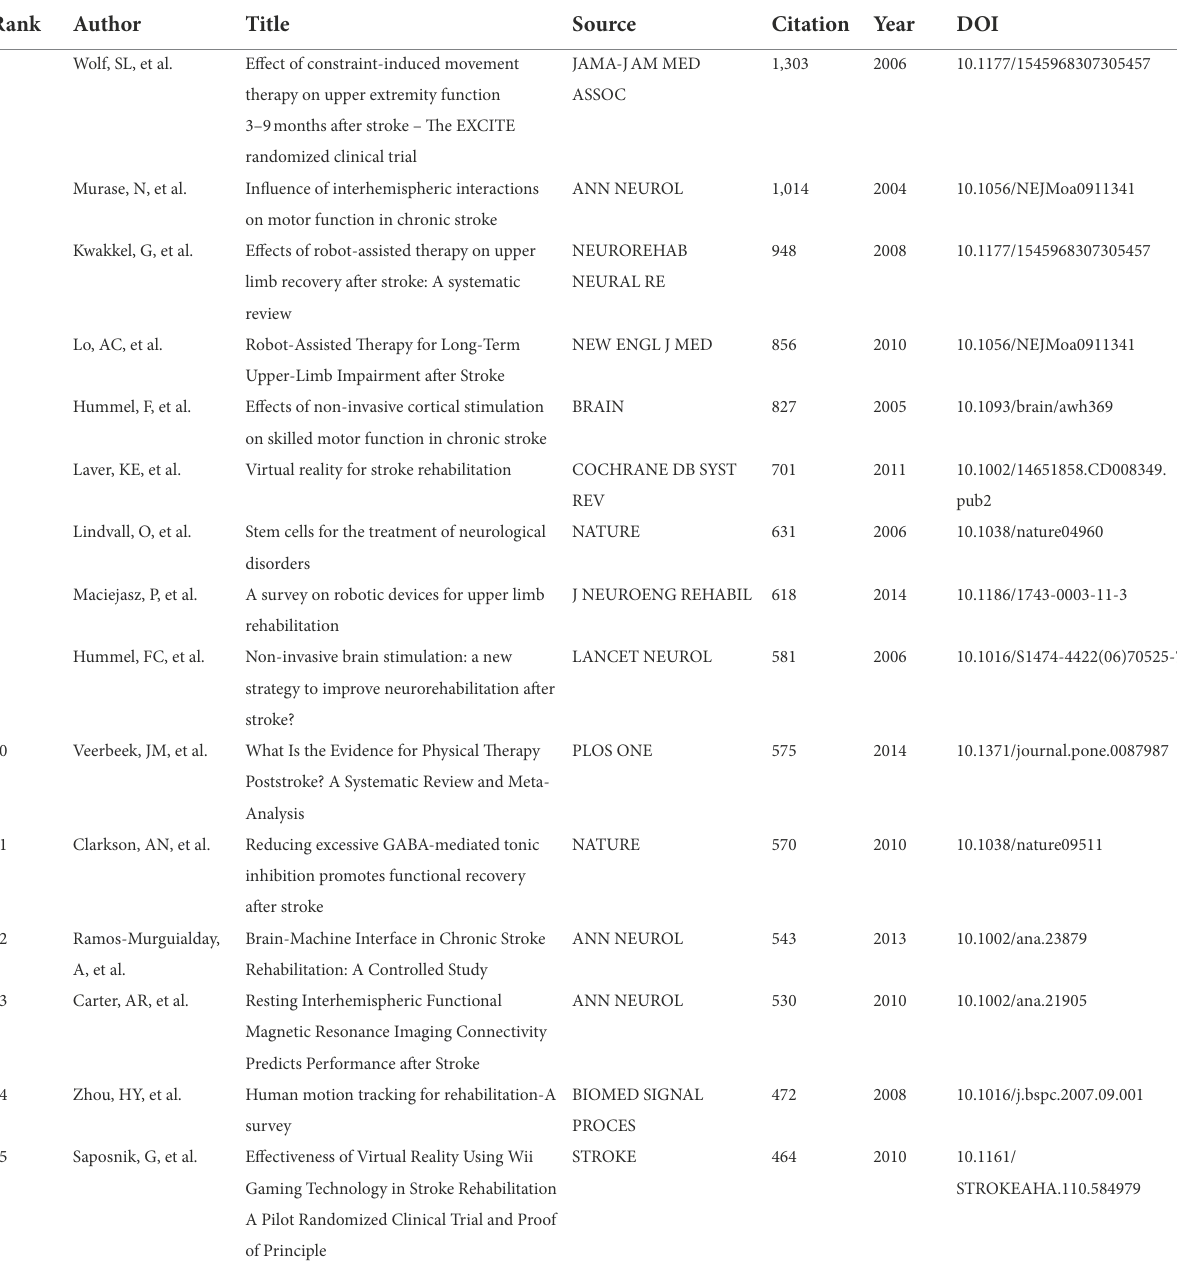
TABLE 4 Top 15 co-cited references related to stroke motor function